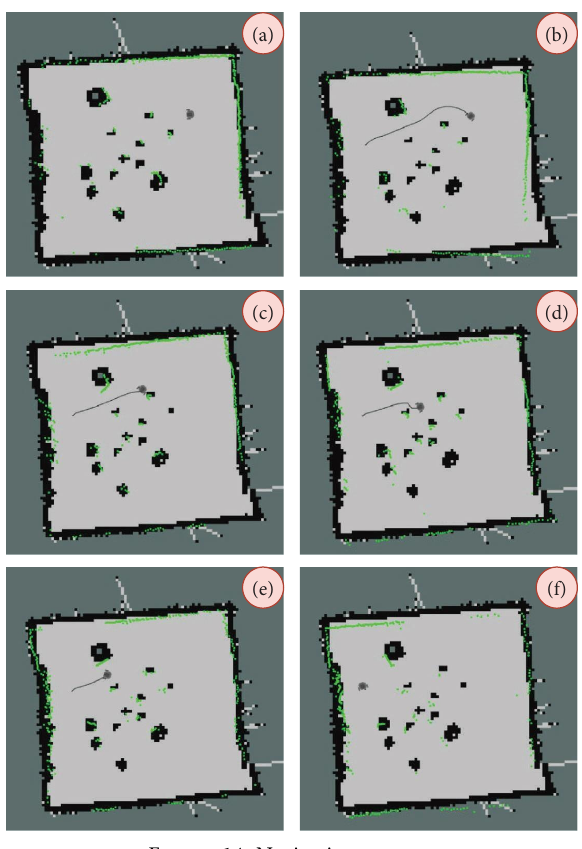
Figure 14: Navigation process. Table 3: Amazon EC2